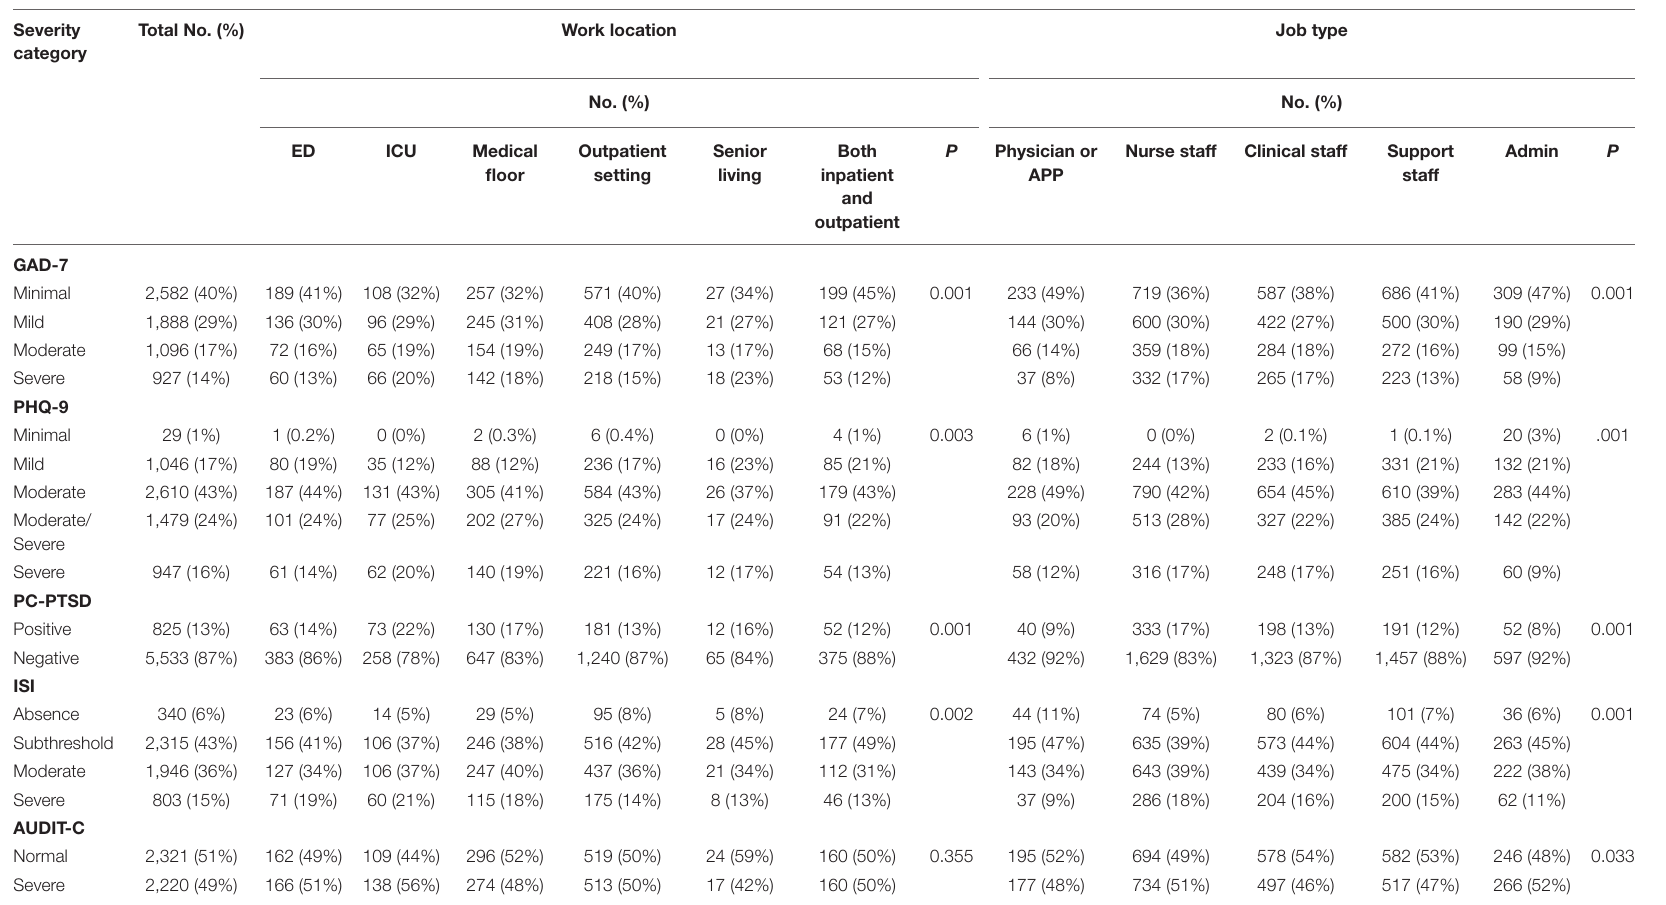
TABLE 3 | Rates of depression, anxiety, post-traumatic stress disorder (PTSD), and insomnia by job type. Severity